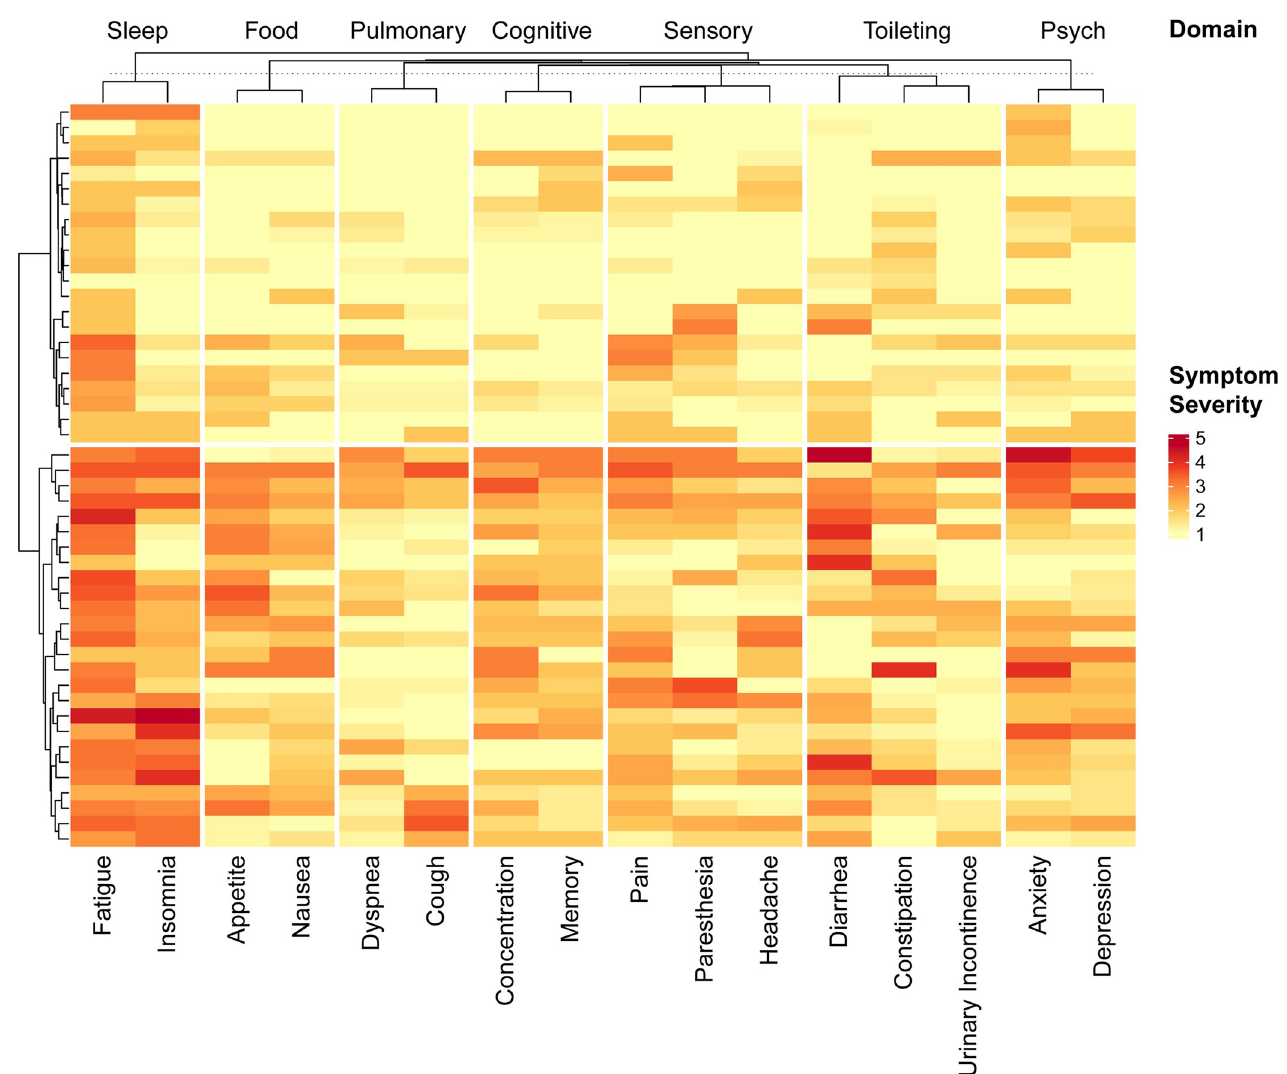
Fig 4. Symptom burden in the PRSM symptom burden instrument. Hierarchical clustering of average responses in the original cohort revealed two distinct cohorts of patients with higher and lower symptom burdens. Questions were organized into clinical domains based on the individual questions and respective